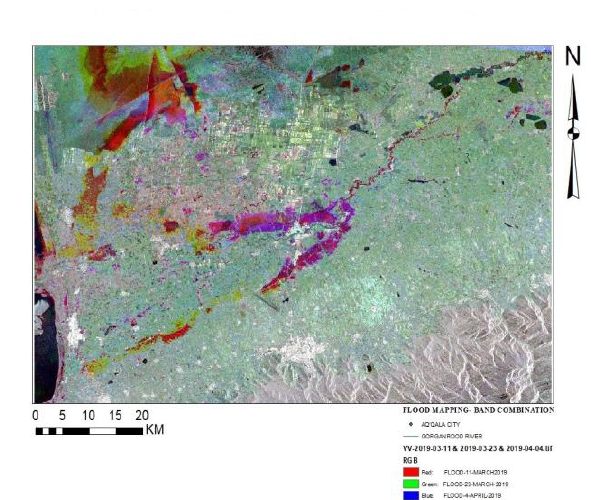
Figure 5. Bands combination in VV channel: Red Band: Flood- 11/3/2019, Green Band: Flood-23/3/2019, Blue Band: Flood- 4/4/2019